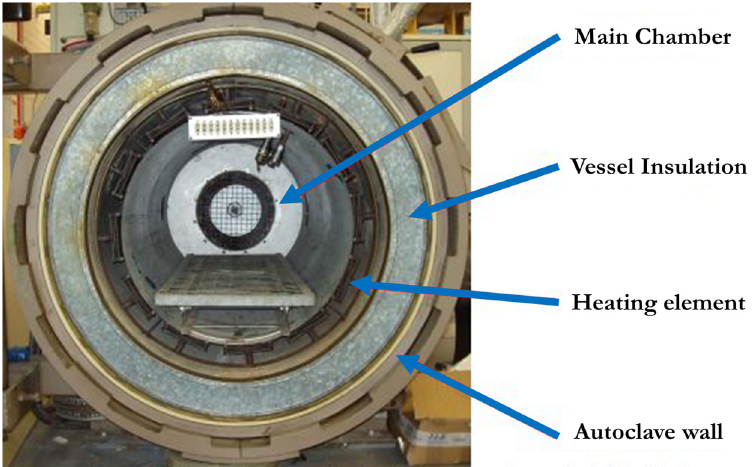
Figure 1. Internal chamber of 0.67 m working diameter Aeroform autoclave at the University of Plymouth.